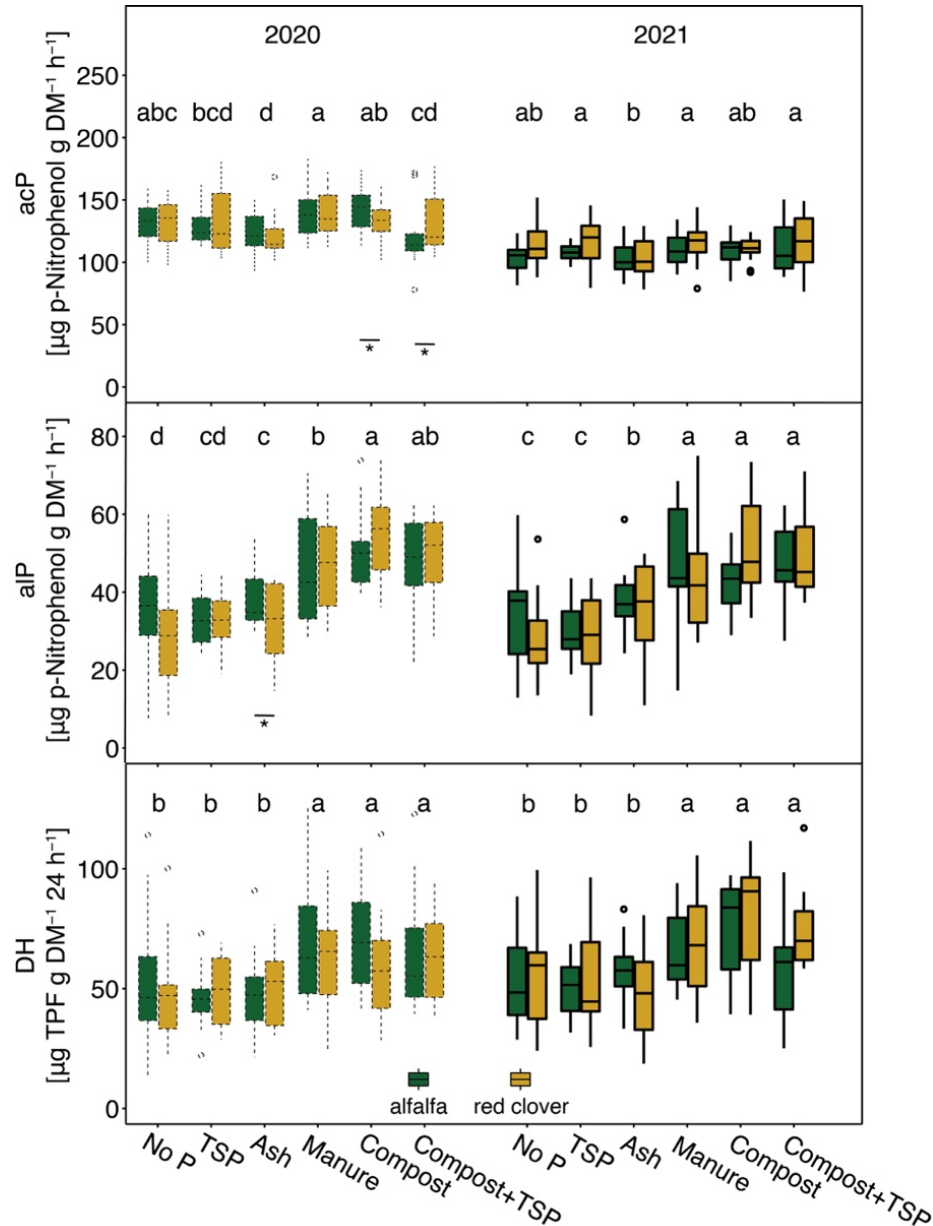
Figure 7. Activities of acid and alkaline phosphatase (acP and alP) and dehydrogenase (DH) in 0 to 20 cm soil depth of the six studied treatments (no P, TSP, ash, manure, compost, and compost + TSP) with cultivation of alfalfa (green) and red clover (brown) in autumn of 2020 (framed with dotted lines) and 2021 (framed with solid lines). Letters indicate a significant difference between treatments (based on average of plant species) within the same year (Duncan’s new multiple range test with p < 0.05). Whiskers and asterisks indicate a significant interspecific difference between the respective treatments. Mean ± standard deviation (n = 12).